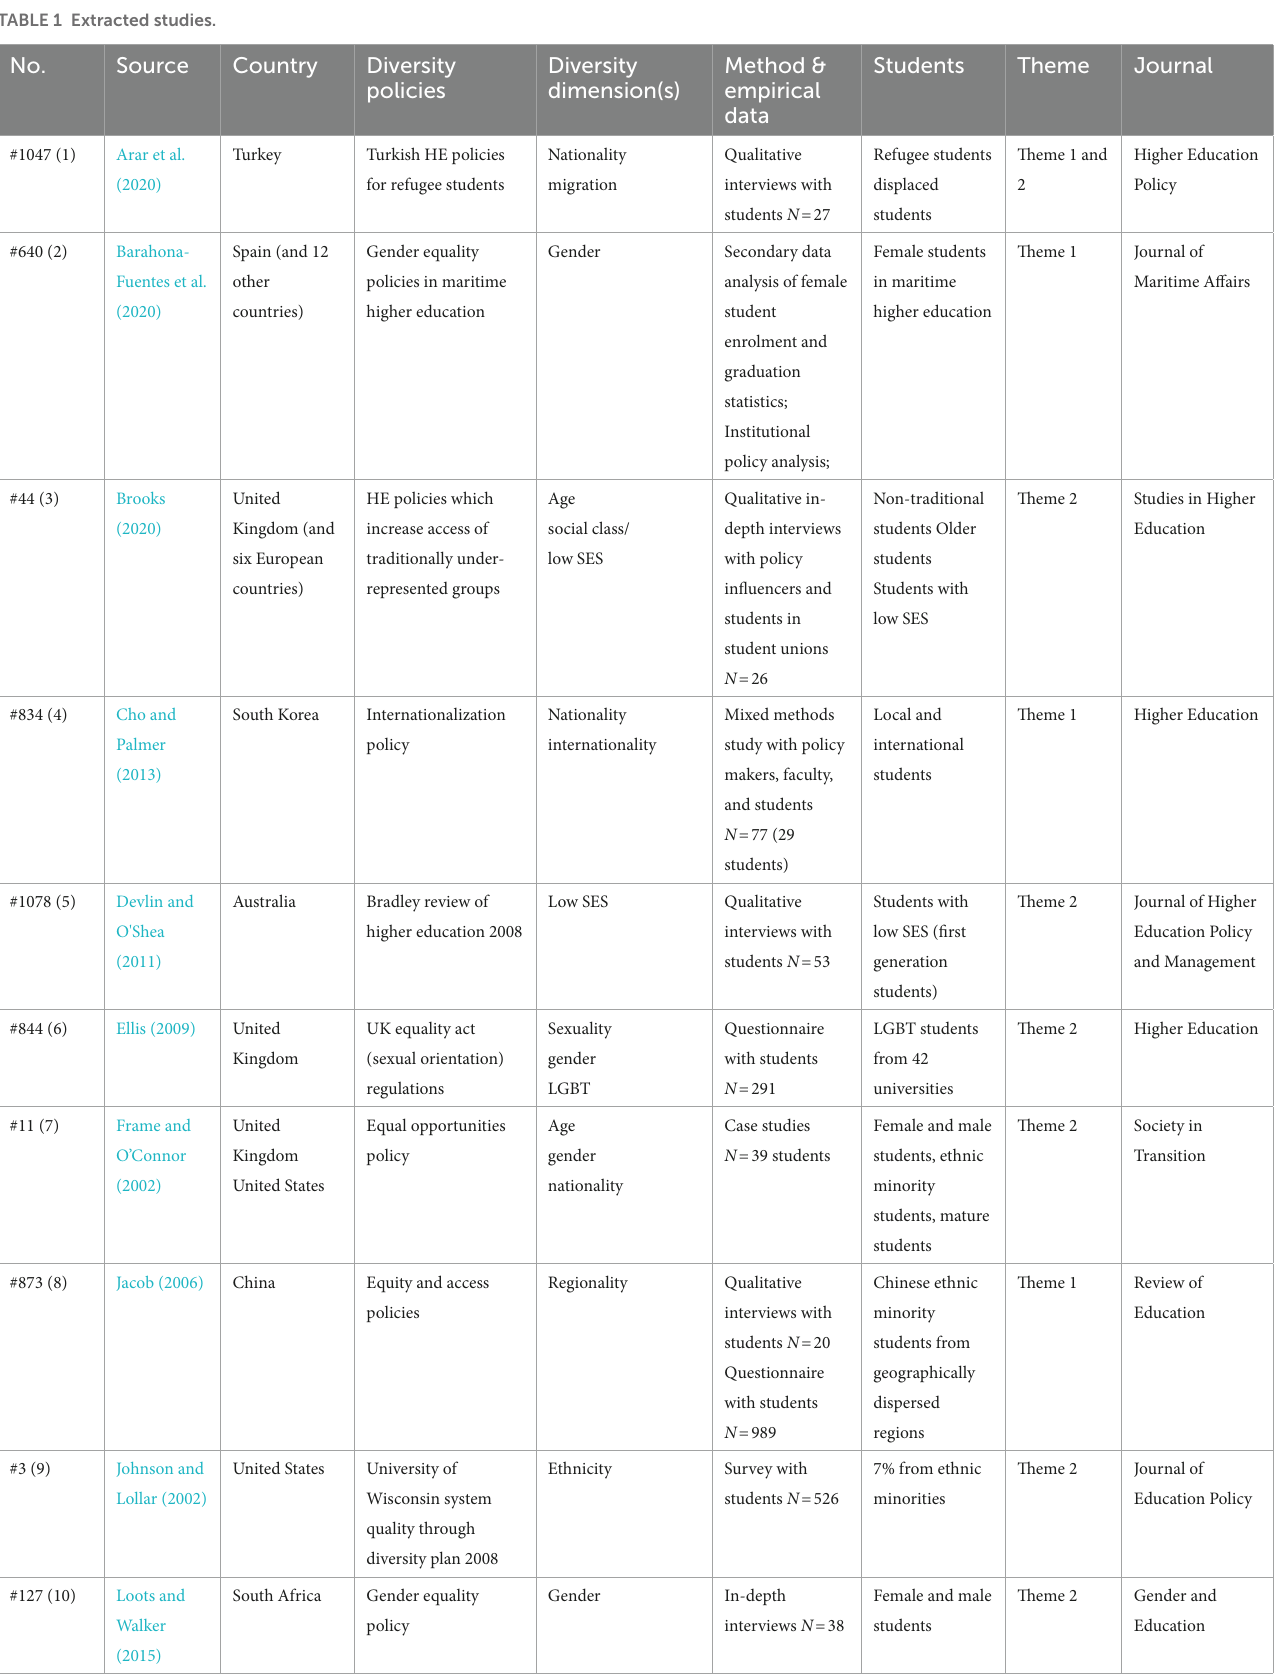
TABLE 1 Extracted studies.